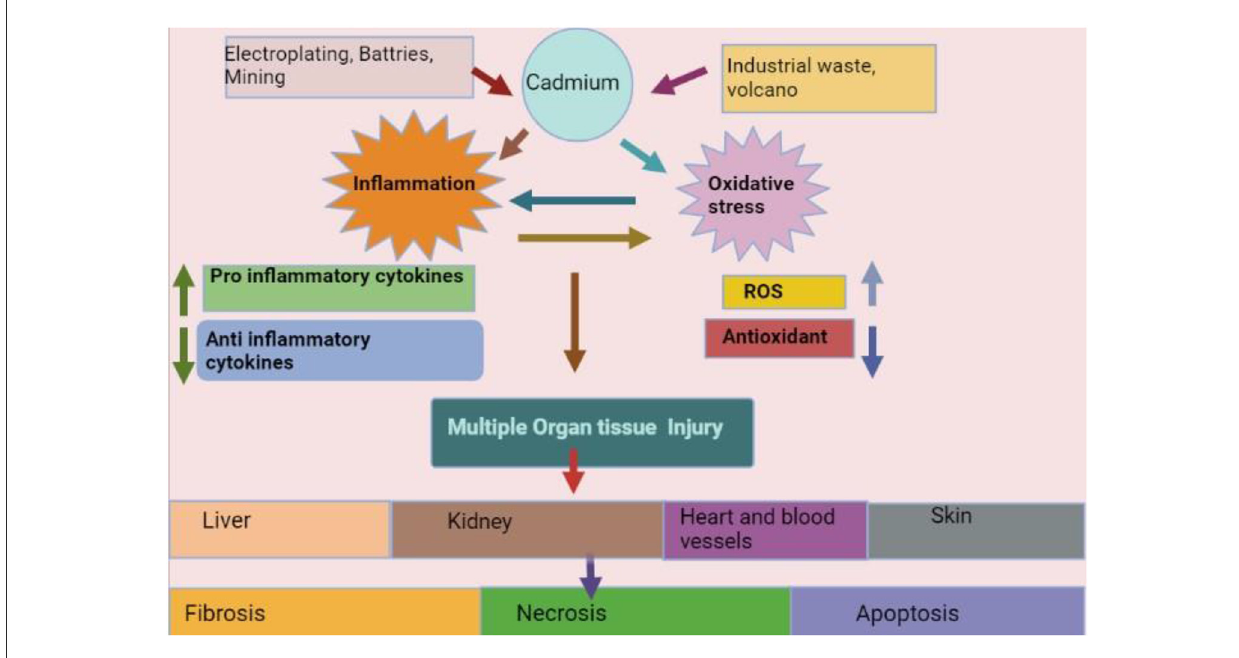
FIGURE4 Source, mechanism, and effects of cadmium (derived from bio